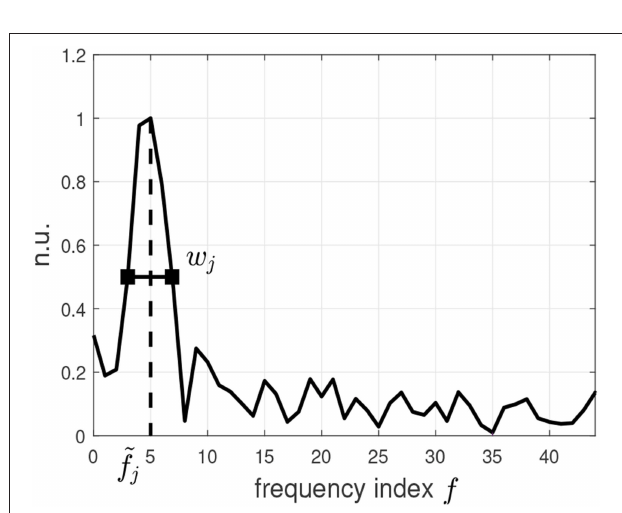
FIGURE 3 | Normalized power spectrum of the first principal component of the matrix B from the example of Figure 2 . The location of the index ˜ f j of the dominant frequency peak and its half height bandwidth w j are also shown. The horizontal axis shows the frequency indices; the vertical axis shows the normalized power spectrum (n.u.: normalized